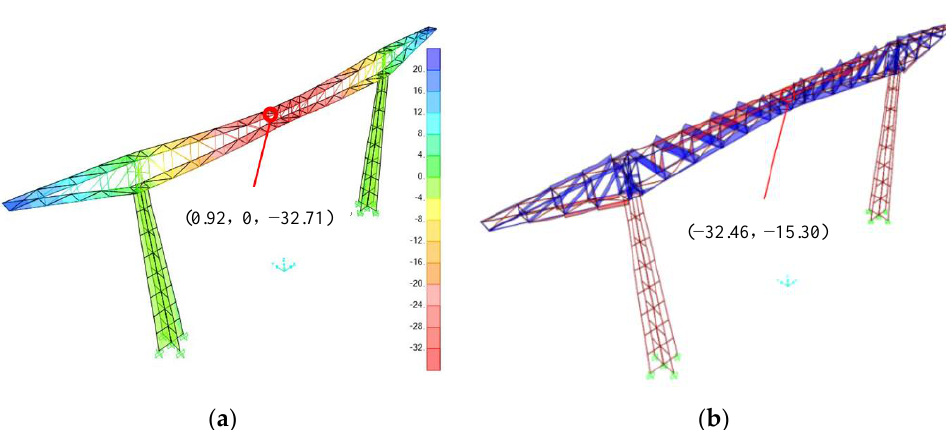
Figure 6. Condition 3. ( a ) Deformation pattern. ( b ) Stress diagram.